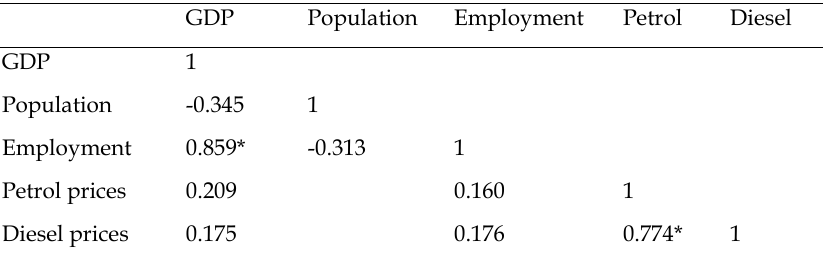
Pearson correlation coefficients of the NTM socio-economic variables